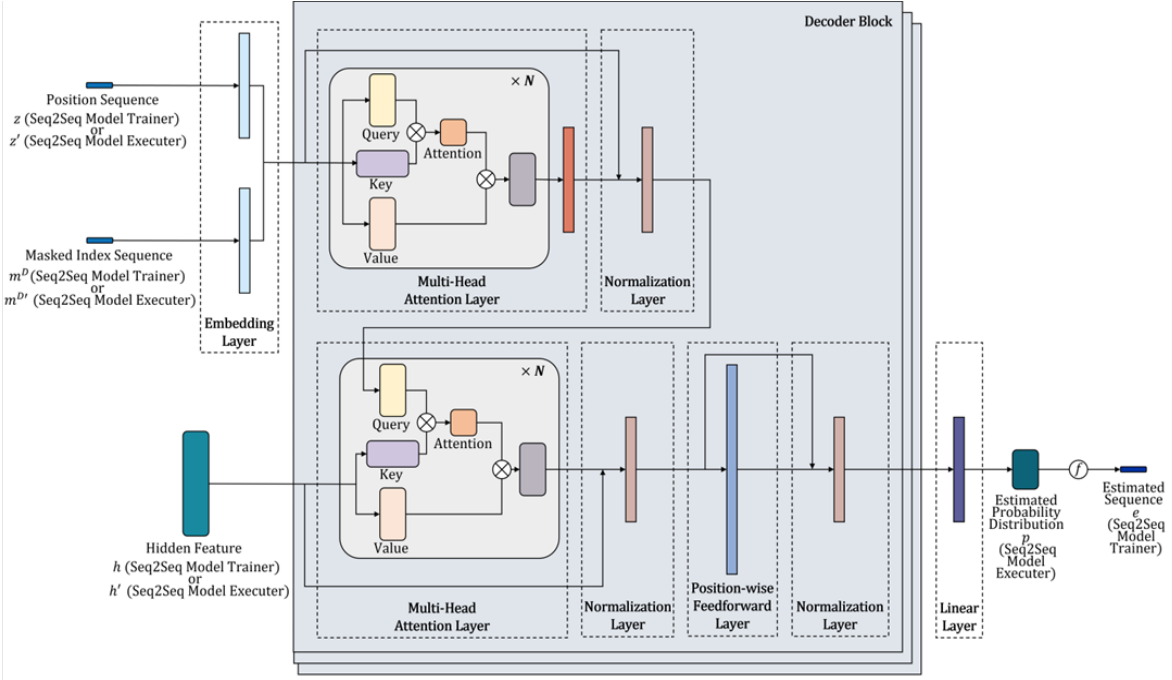
Figure 9. Decoder of the Seq2Seq model.